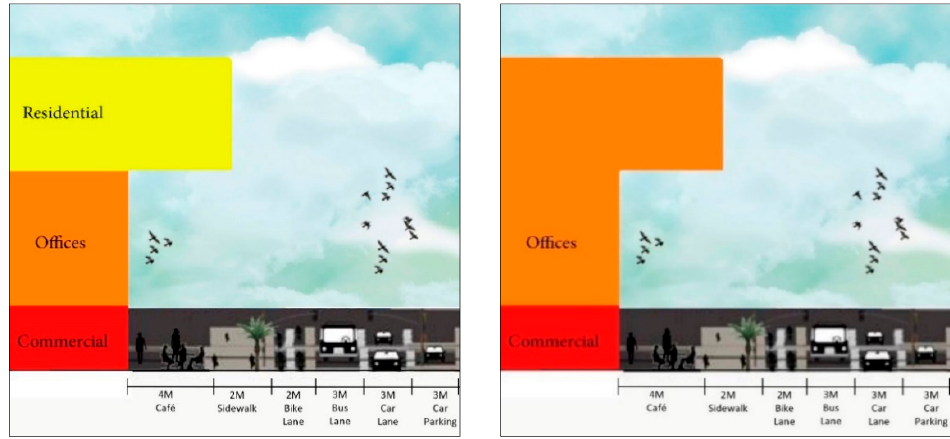
Figure 27. 3D illustration of new land uses (Source: The Authors).